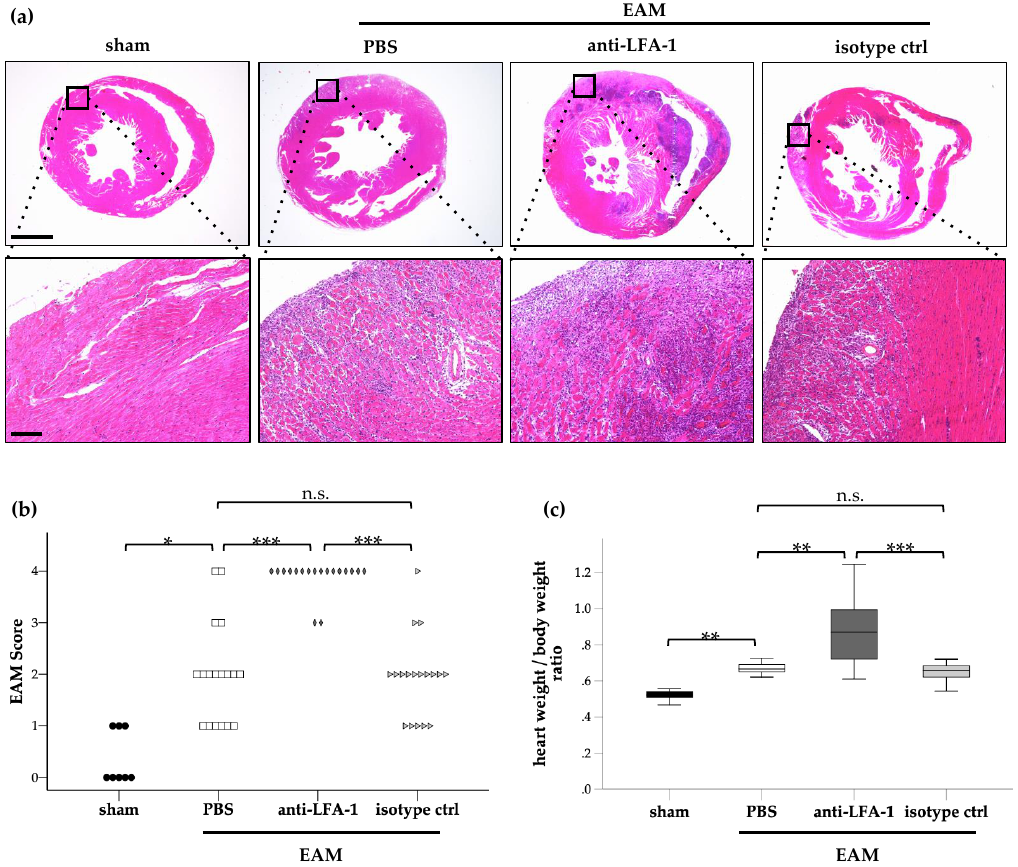
Figure 1. Blocking lymphocyte function-associated antigen 1 (LFA-1) aggravated cardiac inflammation in experimental autoimmune myocarditis (EAM): ( a ) Representative cross sections of heart tissue of sham-treated control mice, vehicle-treated EAM mice (PBS), anti-LFA-1-treated EAM mice as well